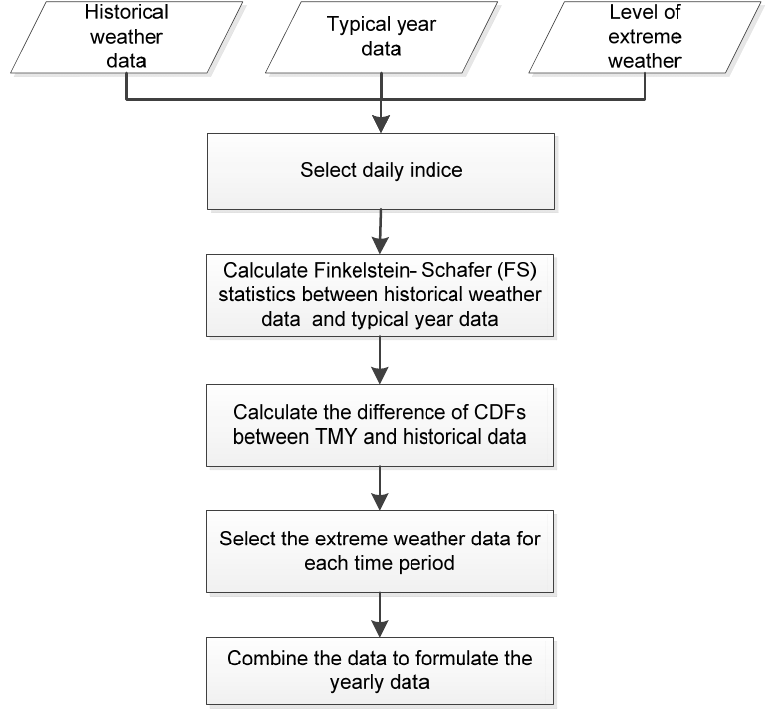
Figure 4. Flow chart of generating extreme weather data from historic weather